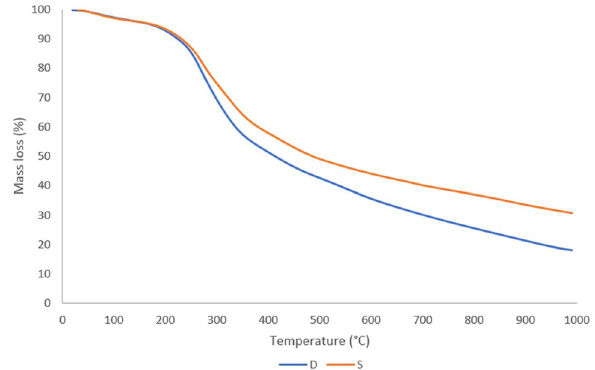
Figure 1. Thermogravimetric curves of raw sewage sludge D & S.